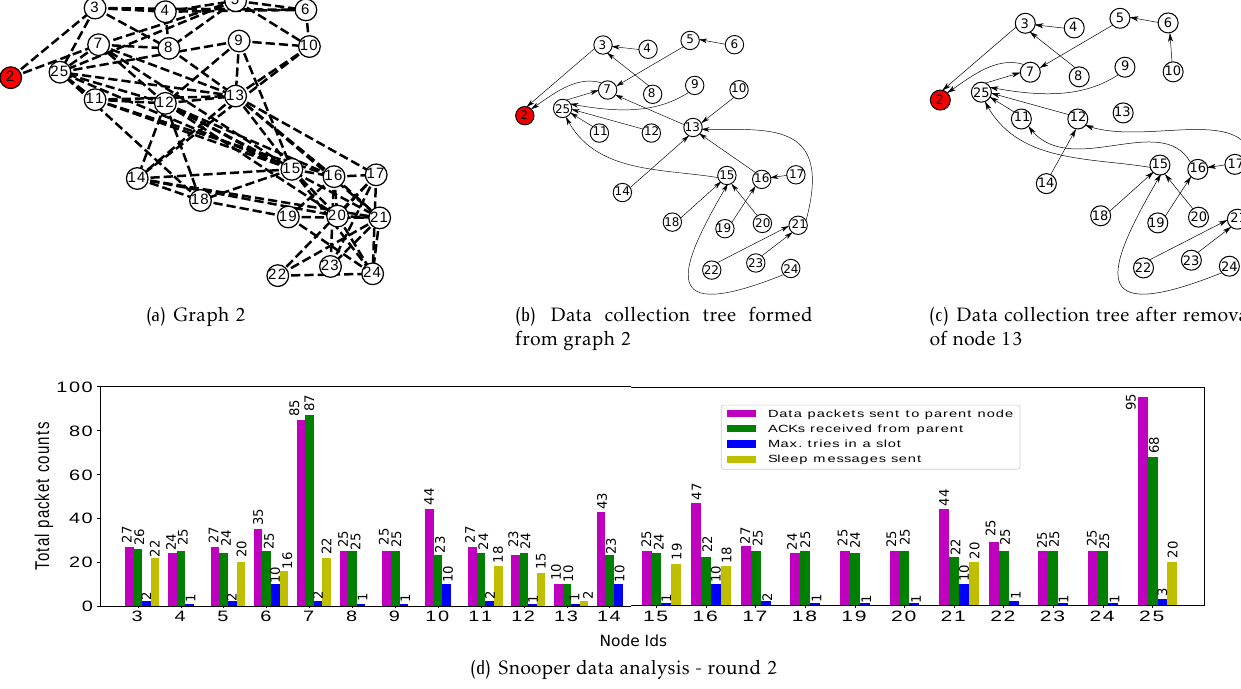
Figure 29. Graphs and the data collection trees - round 2, test case